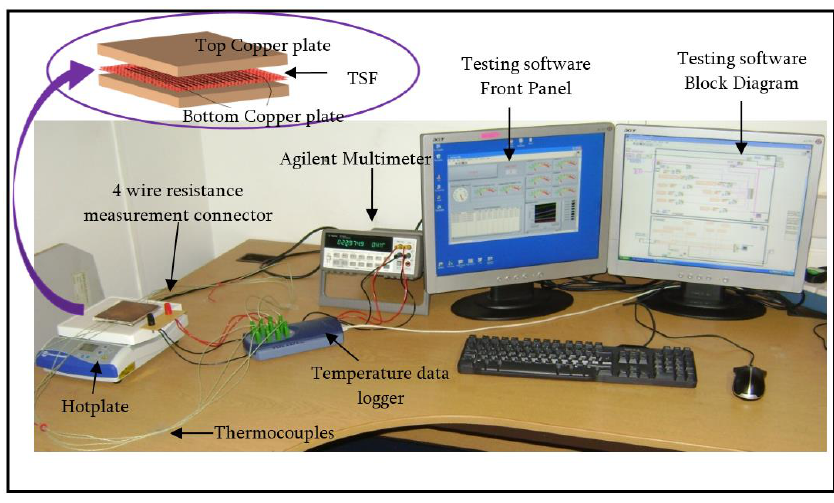
Figure 3. A tailor-made test rig for the development of temperature–resistance (TR) curves of the TSF samples. Reproduced with permission from [7]; Published by Lodz University of Technology, Faculty of Material Technologies and Textile Design, Poland,